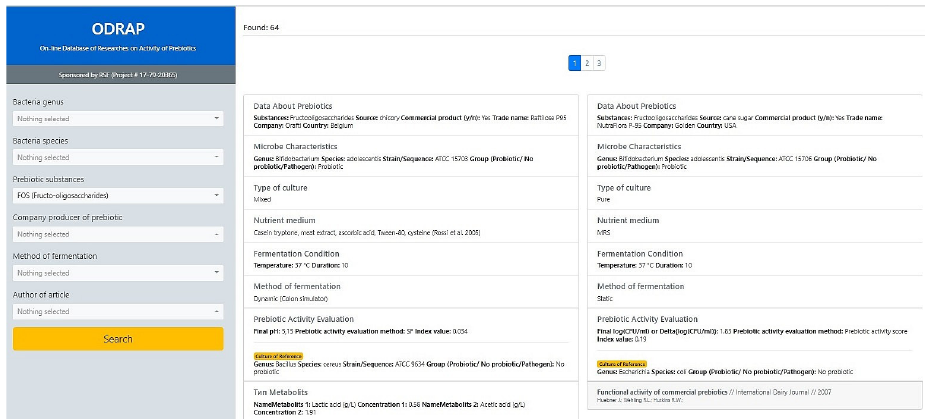
Figure 6. Example of search: FOS (fructo-oligosaccharides) was selected as prebiotic substance, 64 records with FOS were